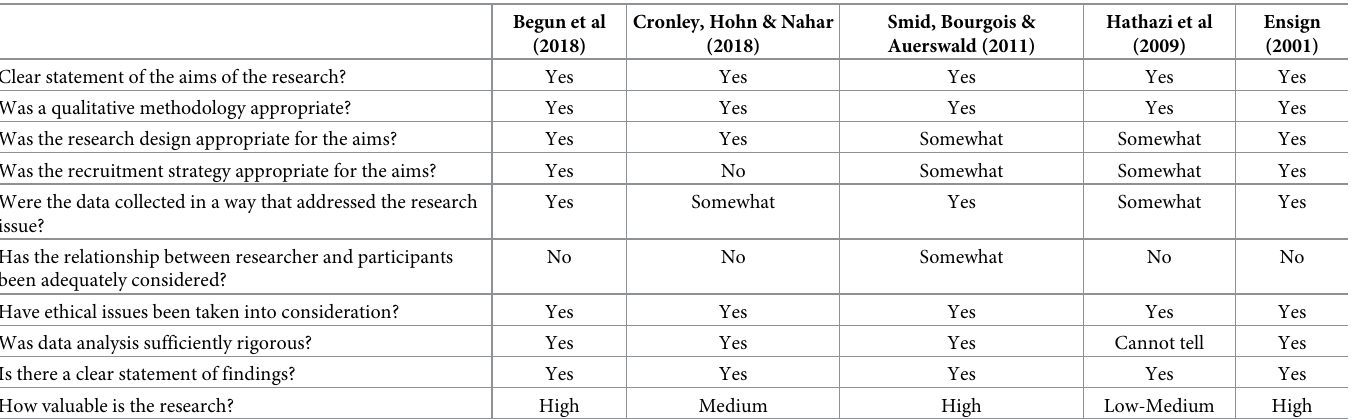
Table 2. Quality appraisal of included